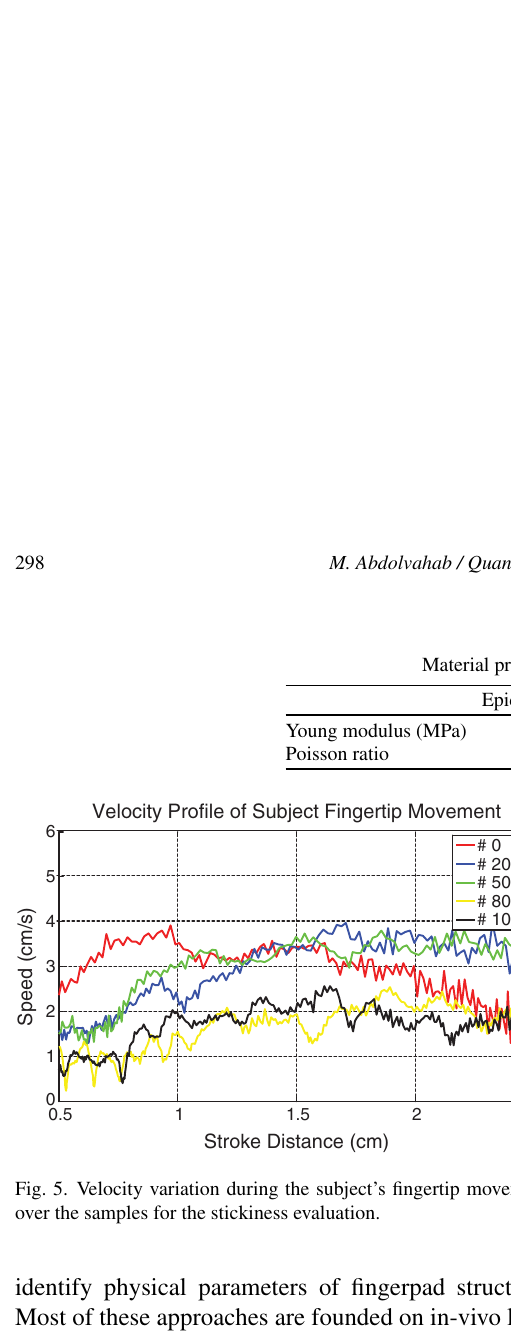
identify physical parameters of fingerpad